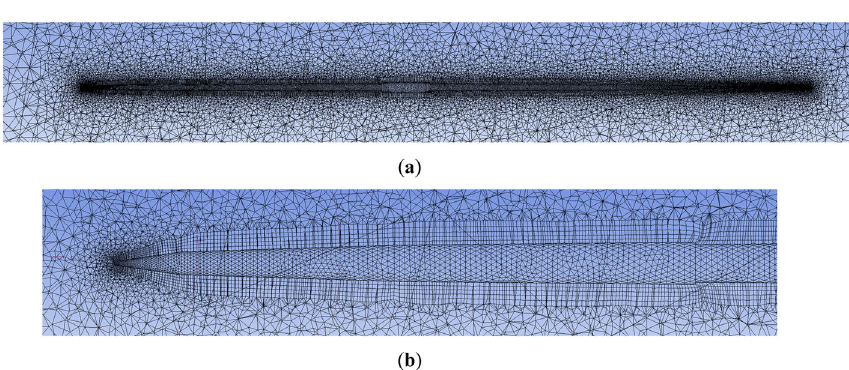
Figure 9. Meshes: ( a ) around the javelin; ( b ) around the javelin’s top.